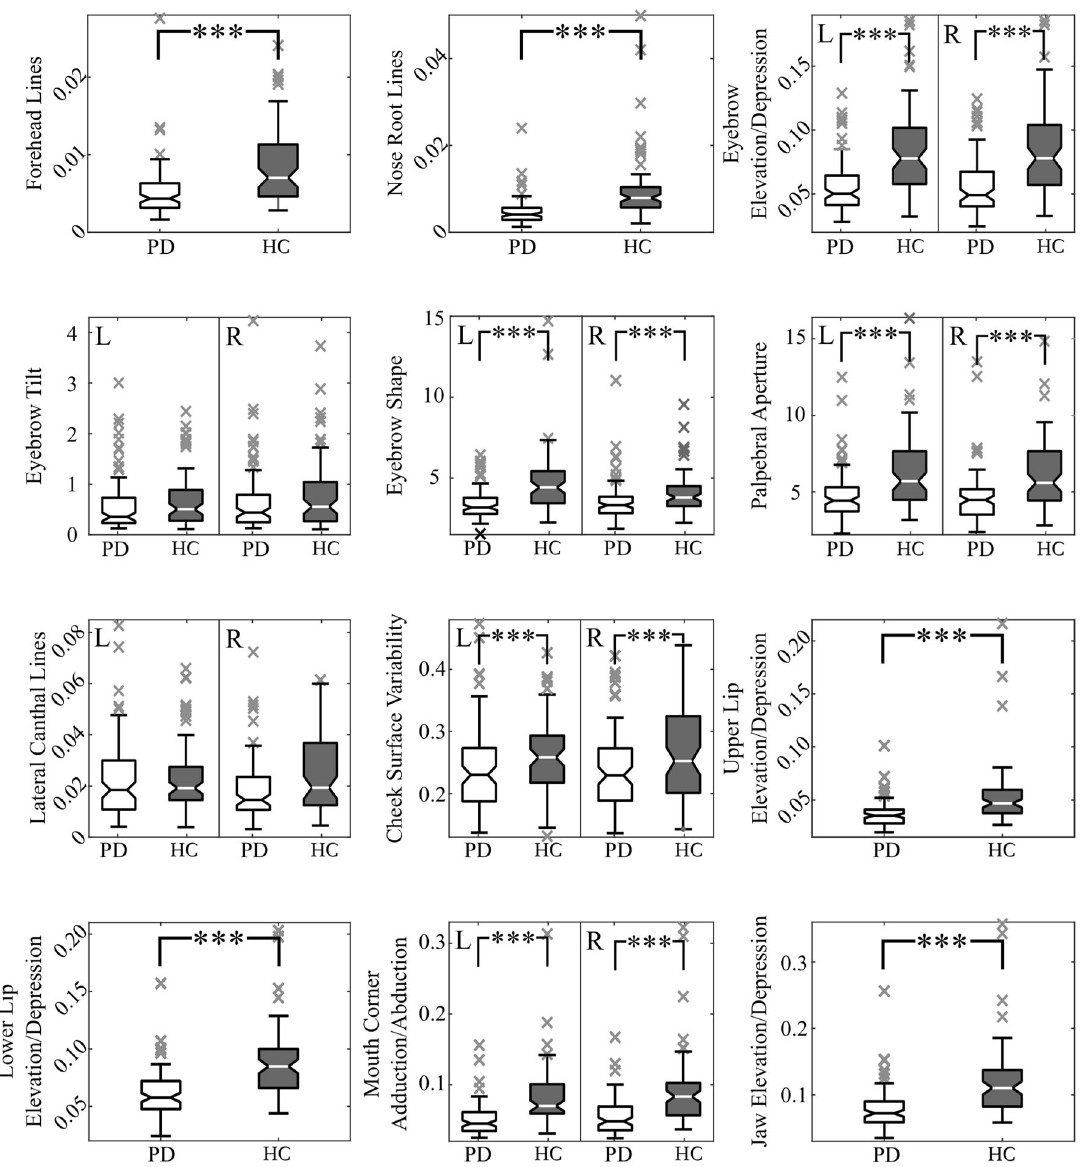
Fig. 1 Depiction of between-group differences for each facial marker. The markers with two-sided variant are presented in the same sub- plot and denoted by L for left side and R for the right side. In the fi gure the centerlines denote feature medians, bounds of boxes represent 25th and 75th percentiles, whiskers denote nonoutlier data range and the crosses denote outlier values. Statistically signi fi cant differences after Bonferroni adjustment are denoted by asterisks: *** p < 0.001. PD = Parkinson ’ s disease; HC = healthy